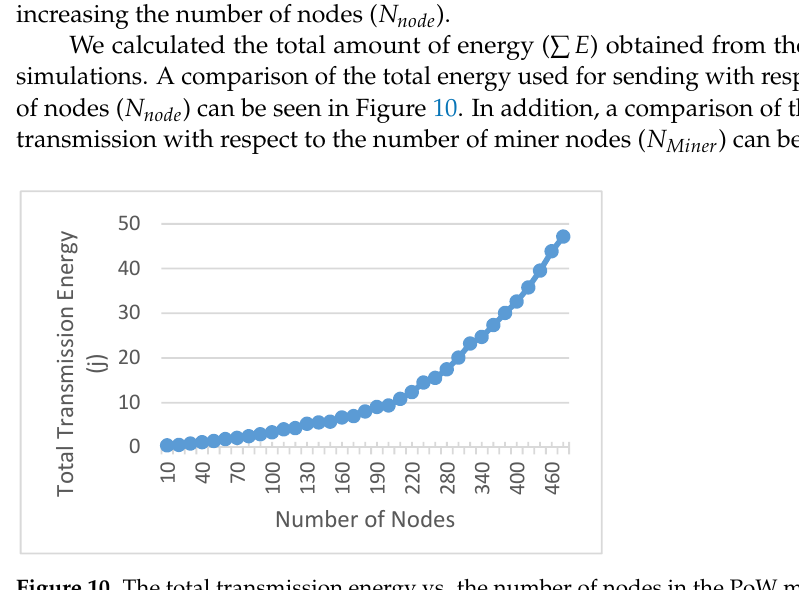
Figure 10. The total transmission energy vs. the number of nodes in the PoW model.